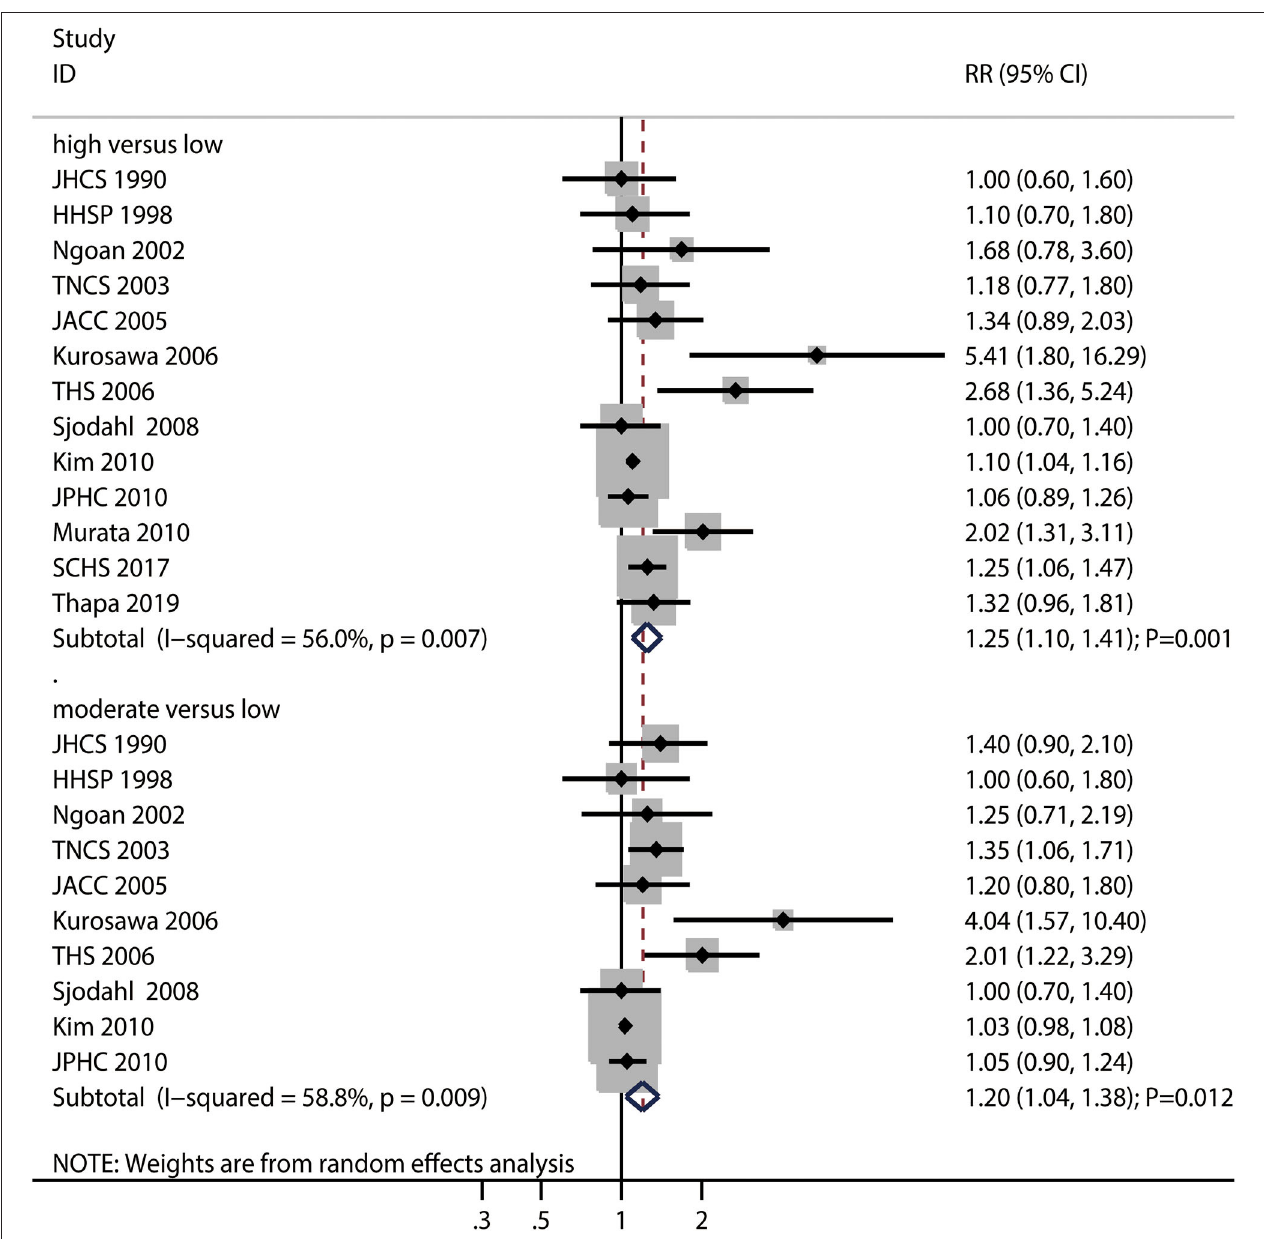
FIGURE 2 | Association between high or moderate salt intake and subsequent gastric cancer